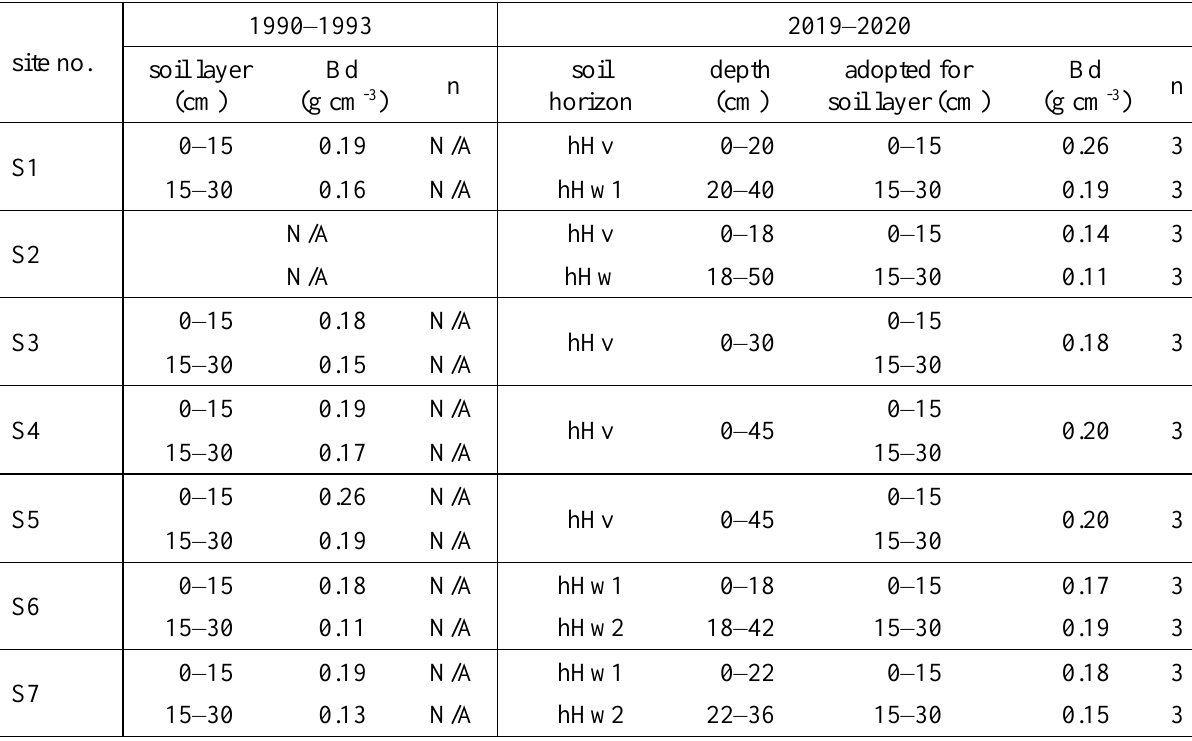
Table A3. Soil bulk densities (Bd), from the initial examination in 1990–1993 (Gebhardt & Knabke 1994) and the follow-up examination in 2019–2020. N/A = data not available.